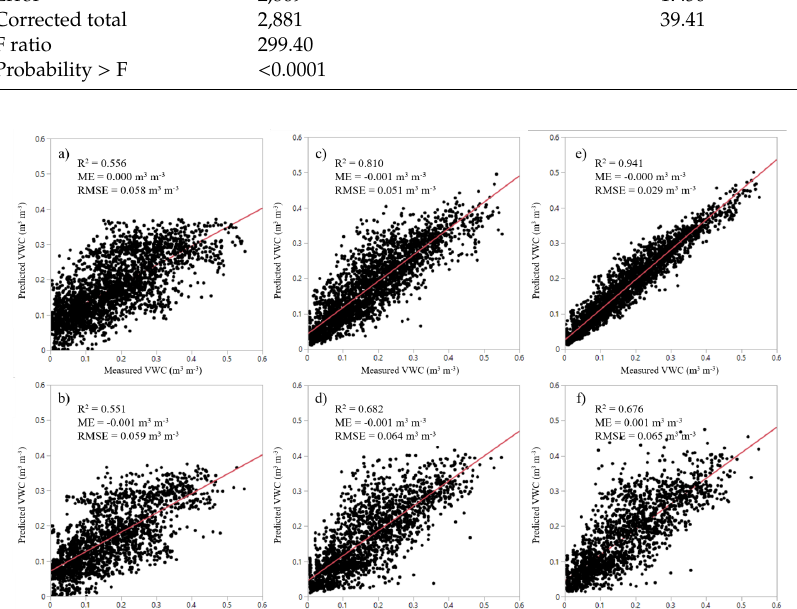
Figure 3. Comparison of model performance based on the 66 U.S. Climate Reference Network stations over 2016 – 2018 for different machine learning algorithms including multiple linear regression model ( a ), Cubist model ( c ), and Random Forest ( e ) for the calibration dataset and multiple linear regression model ( b ), Cubist model ( d ), and Random Forest ( f ) for the validation dataset. Abbreviations: R 2 , coefficient of determination; RMSE, root mean square error (m 3 m − 3 ); ME, mean error (m 3 m − 3 ). In the MLR model, the importance of different covariates can be evaluated based on the P values. As shown in Table 2, VV was the most significant covariate, followed by soil properties such as silt, clay, and LC type. By comparison, terrain parameters (e.g., aspect, TPI) were less important and angle was the least important covariate in the MLR model.